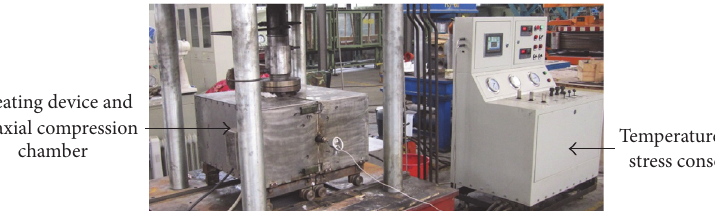
Figure 2: Photograph of high-temperature triaxial permeability test equipment.